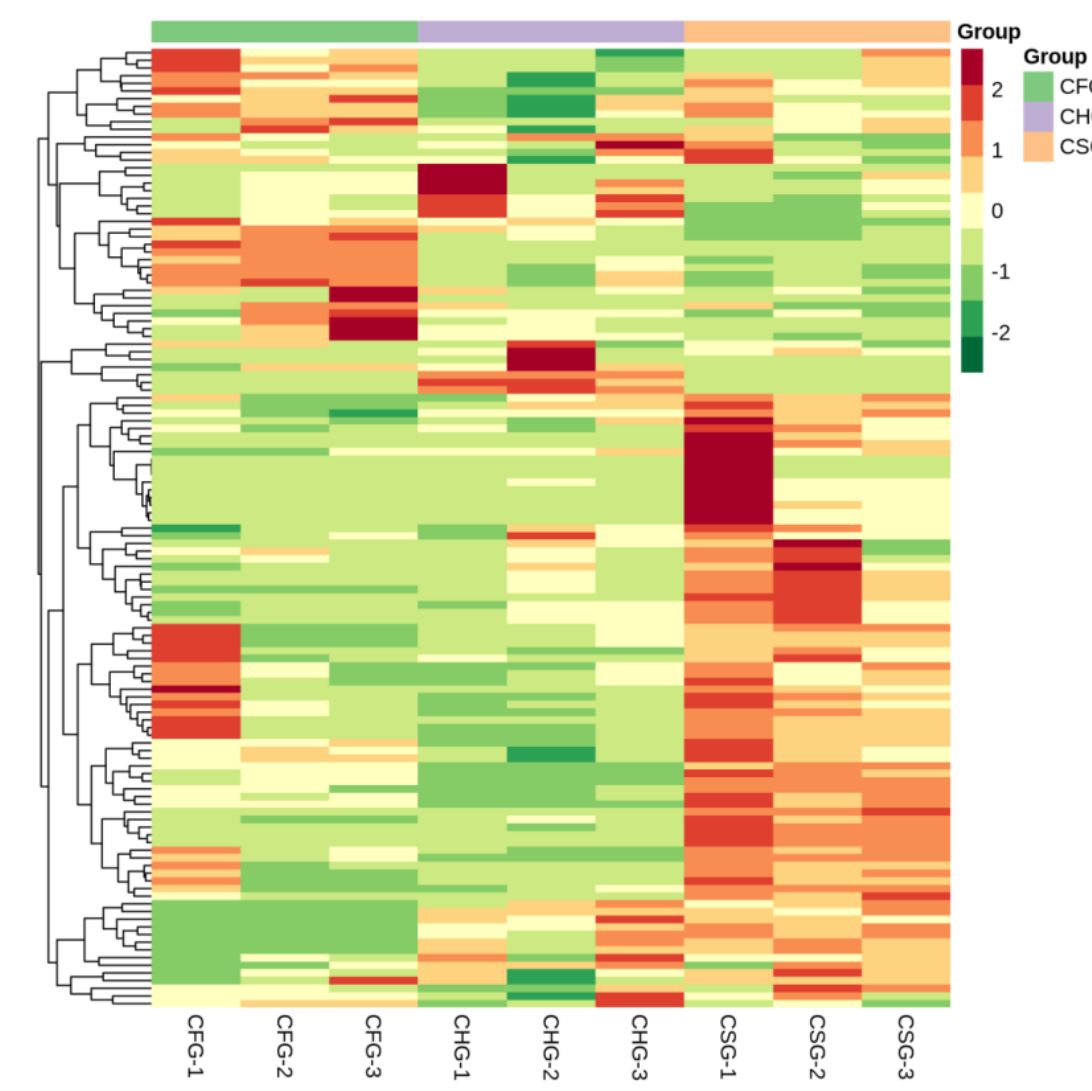
Figure 4. Heatmap of differential metabolites. Metabolite clustering heatmap. The metabolite content data were normalized. Each sample is represented by a column and each metabolite by a row. Red bars indicate high abundance, while green bars indicate low relative abundance (color key scale next to heat map).